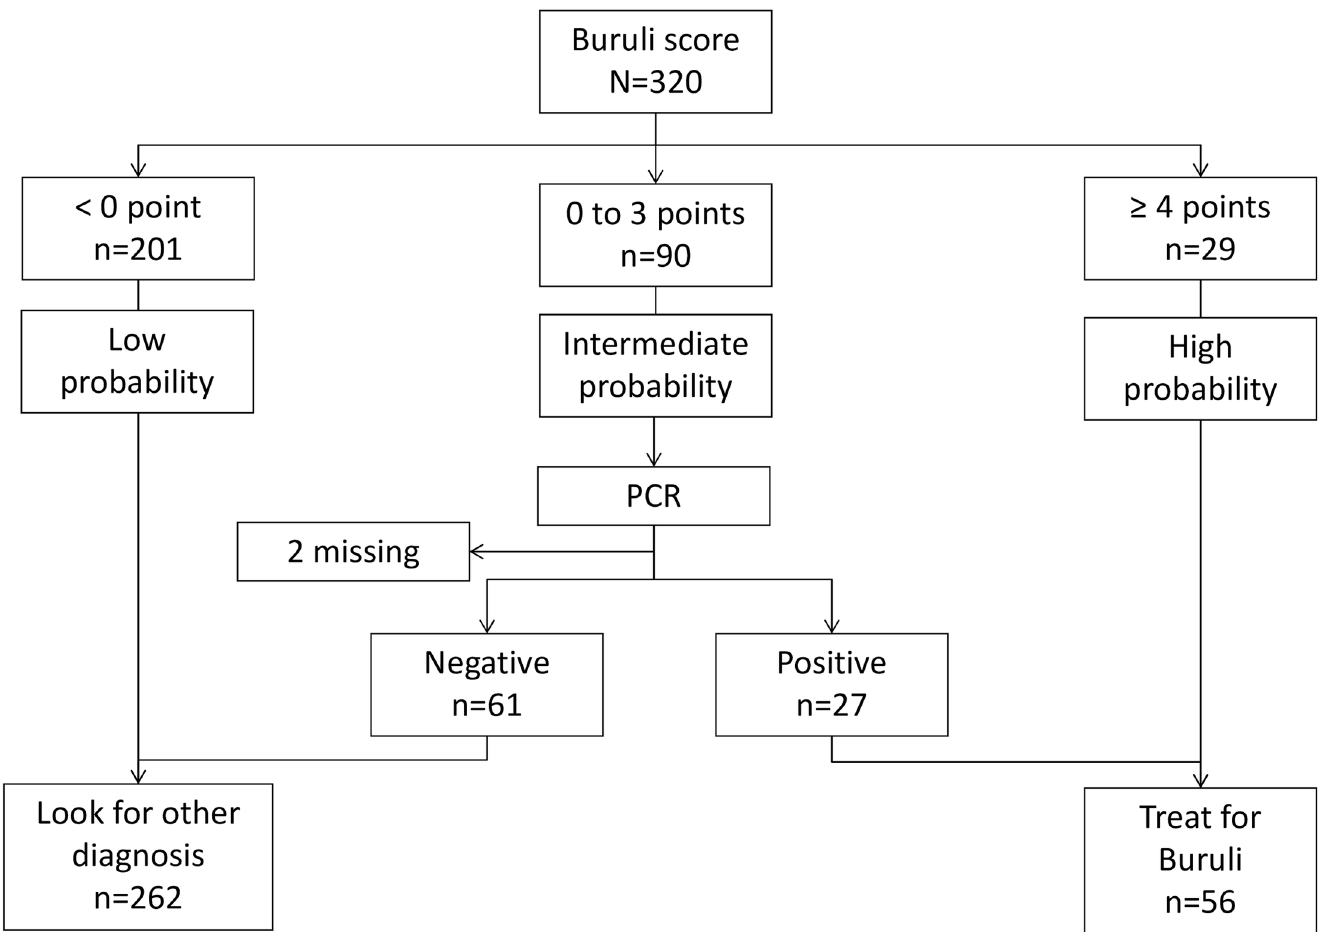
Fig 3. Algorithm based on Buruli score applied to the patients included in the